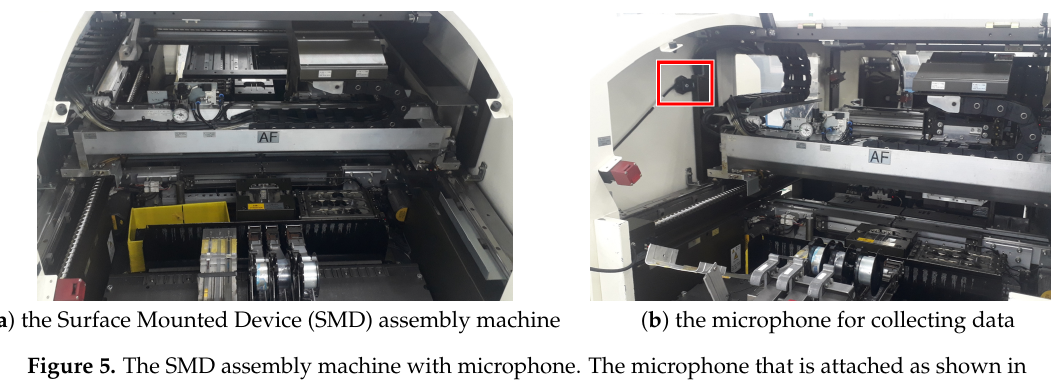
Figure 5. The SMD assembly machine with microphone. The microphone that is attached as shown in ( b ) is used for collecting sound data when the machine is operating.